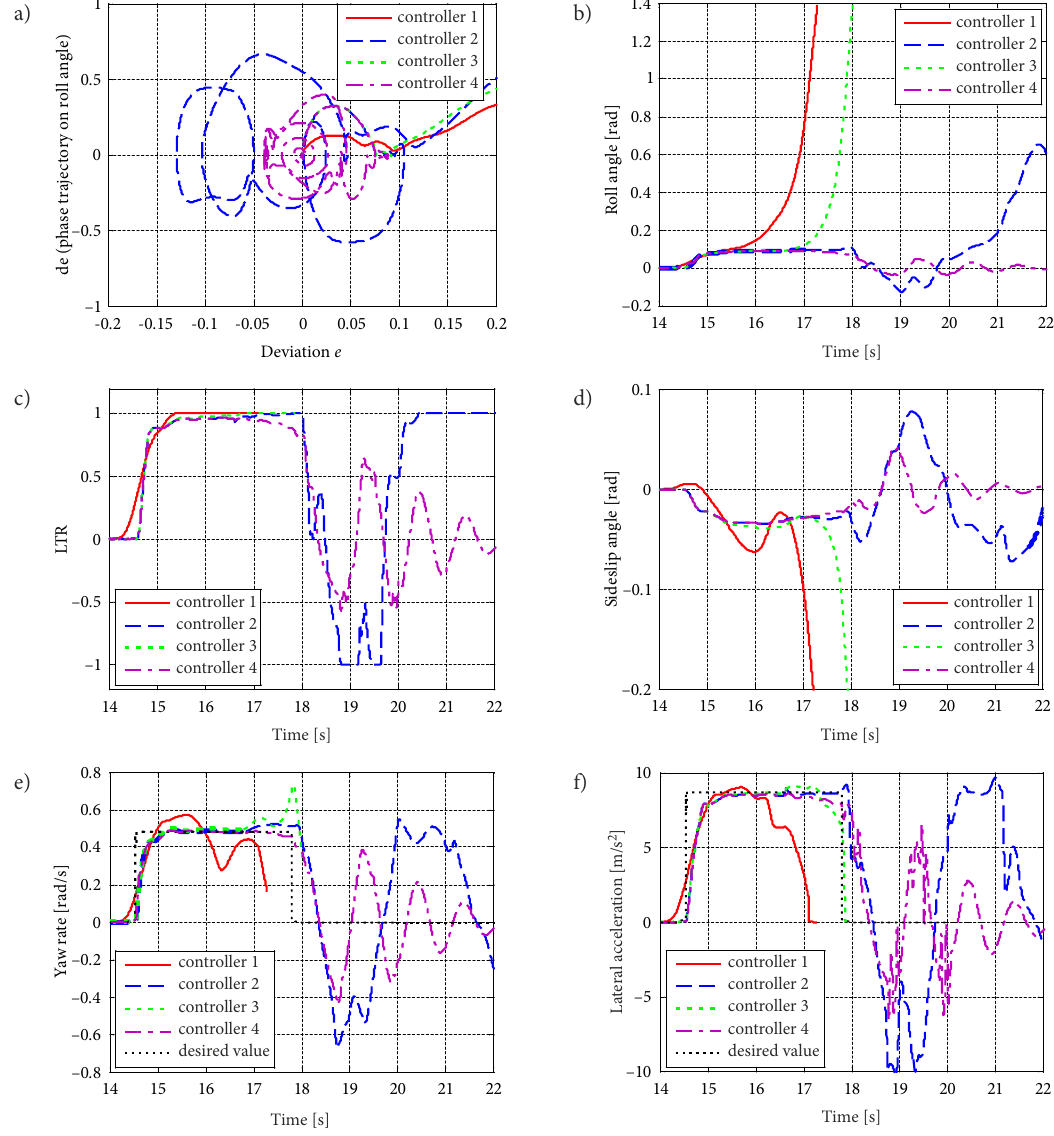
Figure 11. Simulation results in the anti-rollover simulation: a – phase trajectories on the roll angle; b – roll angle; c – LTR value; d – sideslip angle; e – yaw rate; f – lateral